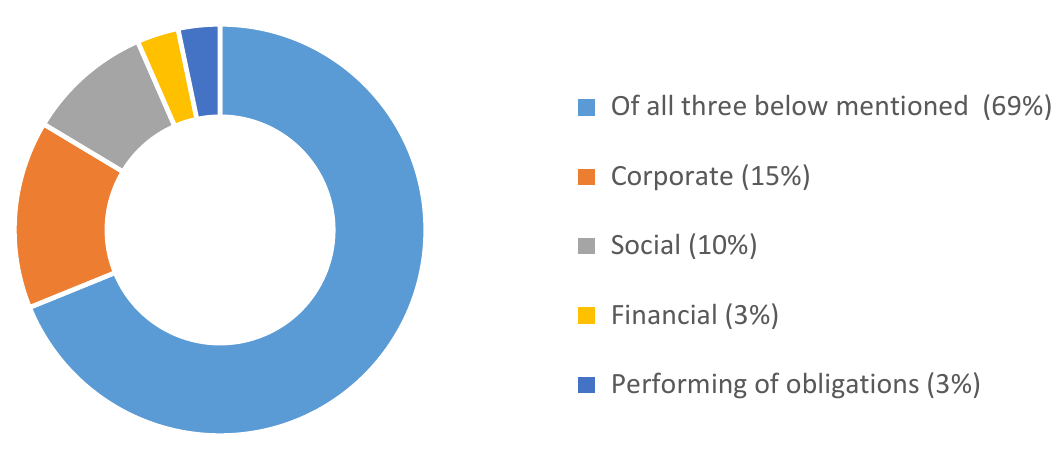
Figure 5. Structural indicators of answers to questions that determine the most commonly used practices of practitioners (SMEs) about the image of the